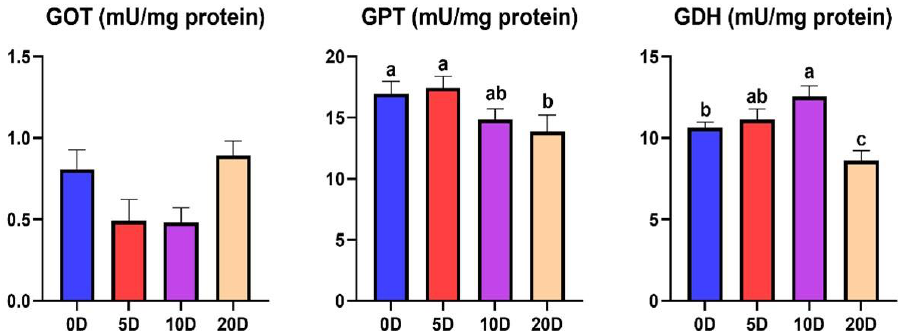
Figure 8. Means ± SEM of the enzyme activities ( n = 18 per treatment) related to protein metabolism in the liver. a, b, c Different letters indicate significant differences between the pre-slaughter times ( p < 0.05). GOT: aspartate aminotransferase; GPT: alanine aminotransferase; GDH: glutamate dehydrogenase. Transformation data for parameters when performing analysis of variance: GOT (square root). In the transformed variables, the SEM are presented for the transformed data and means are presented as back-transformed for better interpretation.